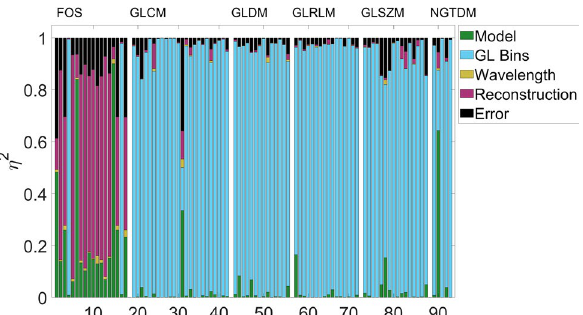
Figure 2. Sensitivity contributions of factors investigated in final radiomics metrics results. First-order statistics are mostly sensitive to variations in the reconstruction type, whereas texture features can be seen to be mostly sensitive to grey level binning variations. Two features, Skewness and Kurtosis , can be seen to be robust to these changes and mostly sensitive to variations in the tumour model. The feature IDs (x-axis) follows Supplementary Tables ST1 and